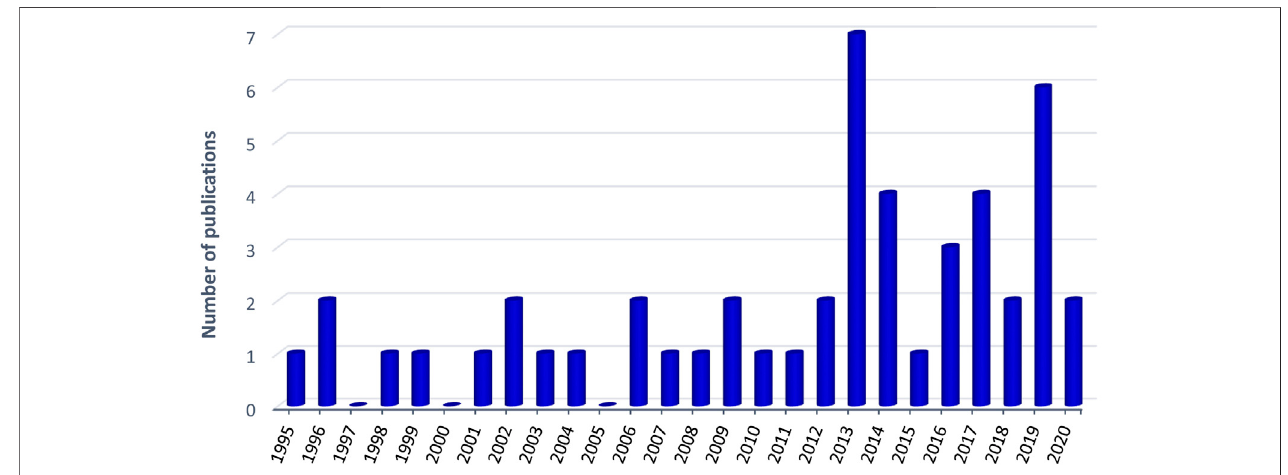
FIGURE 4 | Annual publication rate of Eriosema genus since 1995 (phytochemical, pharmacological and toxicological investigation and reviews).